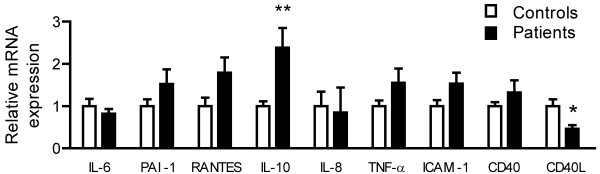
mRNA expression of IL-6, PAI-1, RANTES, IL-10, IL-8, TNF-a, ICAM-1, CD40, and CD40L in 9 patients with CNPA and 10 healthy controls as assessed by real-time quantitative RT-PCR. Data are mean ± SEM in relation to the control gene β-actin and healthy controls are normalized equal to 1. *p < 0.05 and **p < 0.01 versus controls.